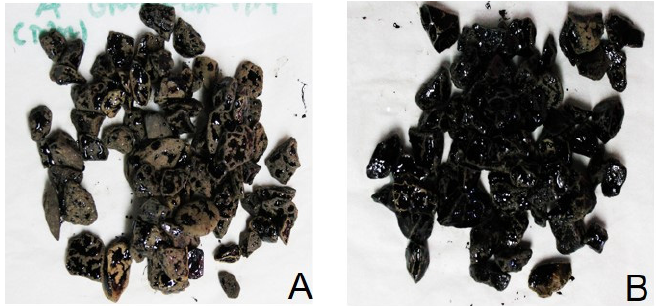
Figure 3. Surface aggregate areas covered with ( A ) untreated bitumen and ( B ) pre ‐ blended bitumen with organosilanes ‐ based adhesion promoters (OSAPs) to a final concentration of 0.01% wt. Reproduced with permission from [40], Elsevier,